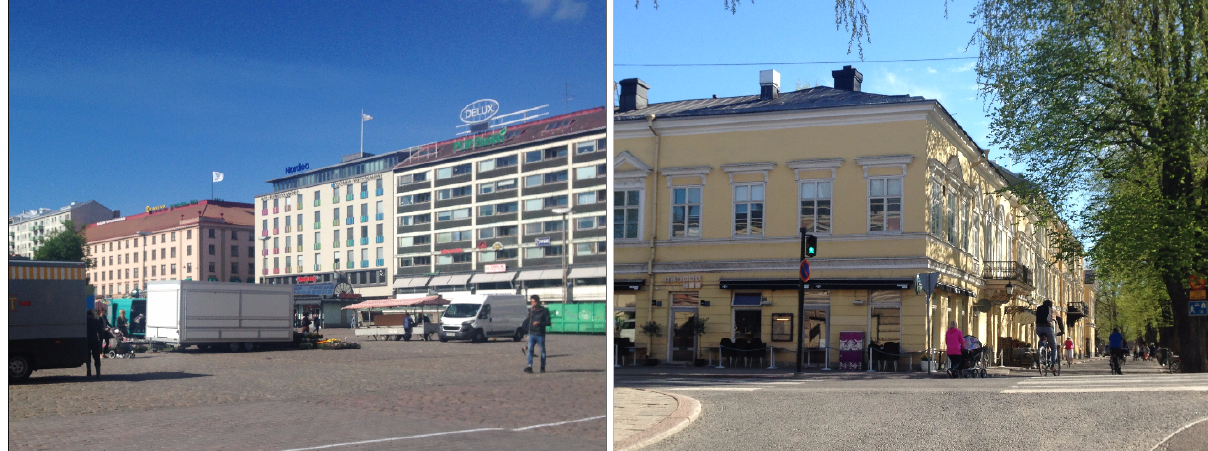
Figure 4. The Market Place (left) and the Riverfront Promenade